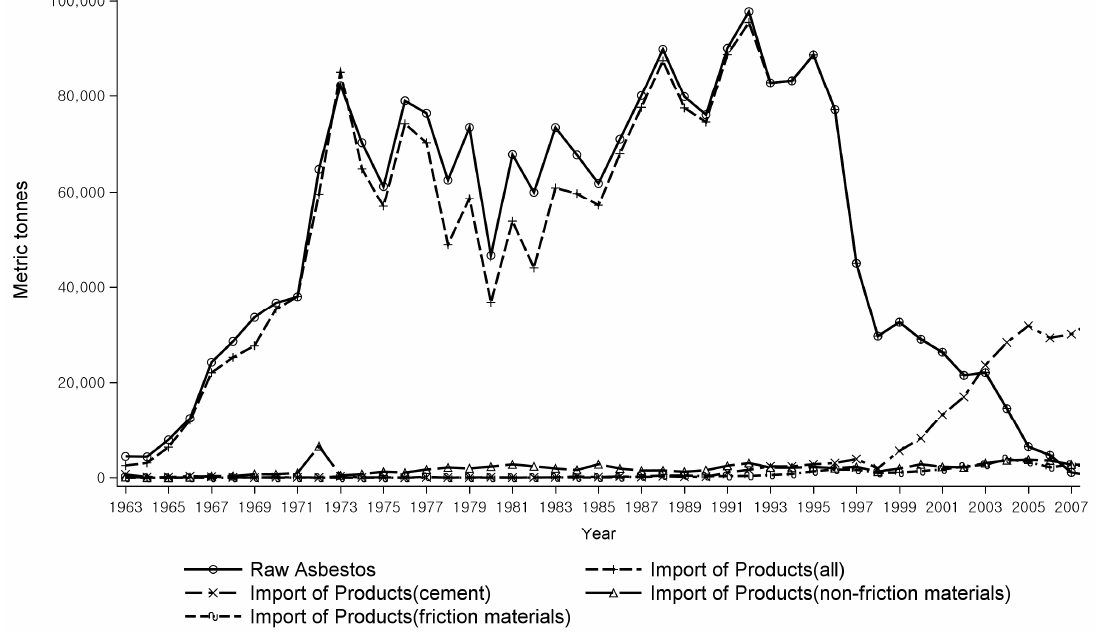
Figure 1. The amount of raw asbestos and asbestos products imported to Korea during 1963–2009.